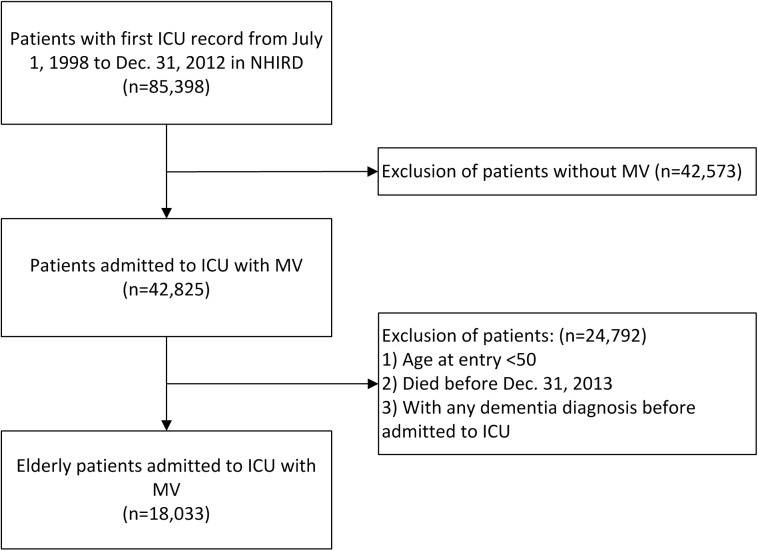
Flowchart of selection of study subjects.